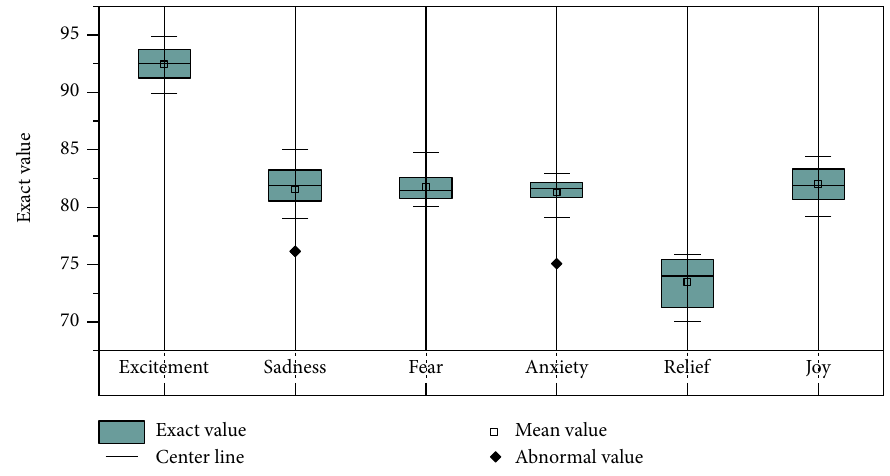
Figure 8: Adaptive matching e ff ect of music unit validation